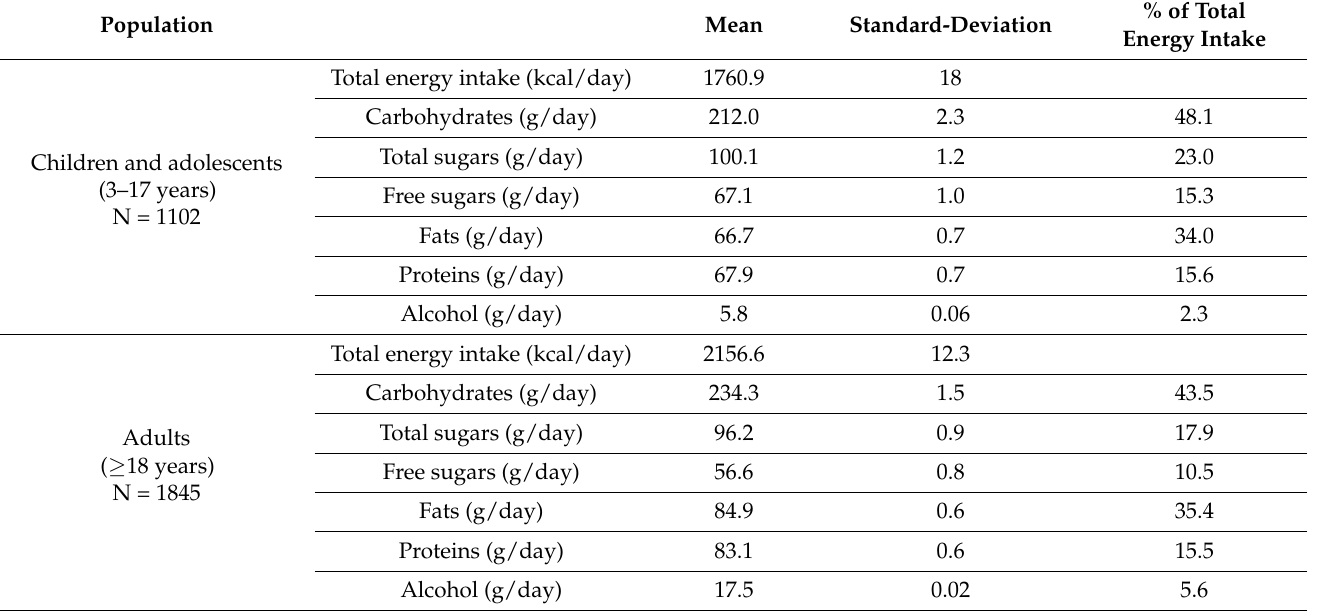
Table 1. Overall intake of macronutrients in children and adolescents as well as in adults. Population Mean Standard-Deviation